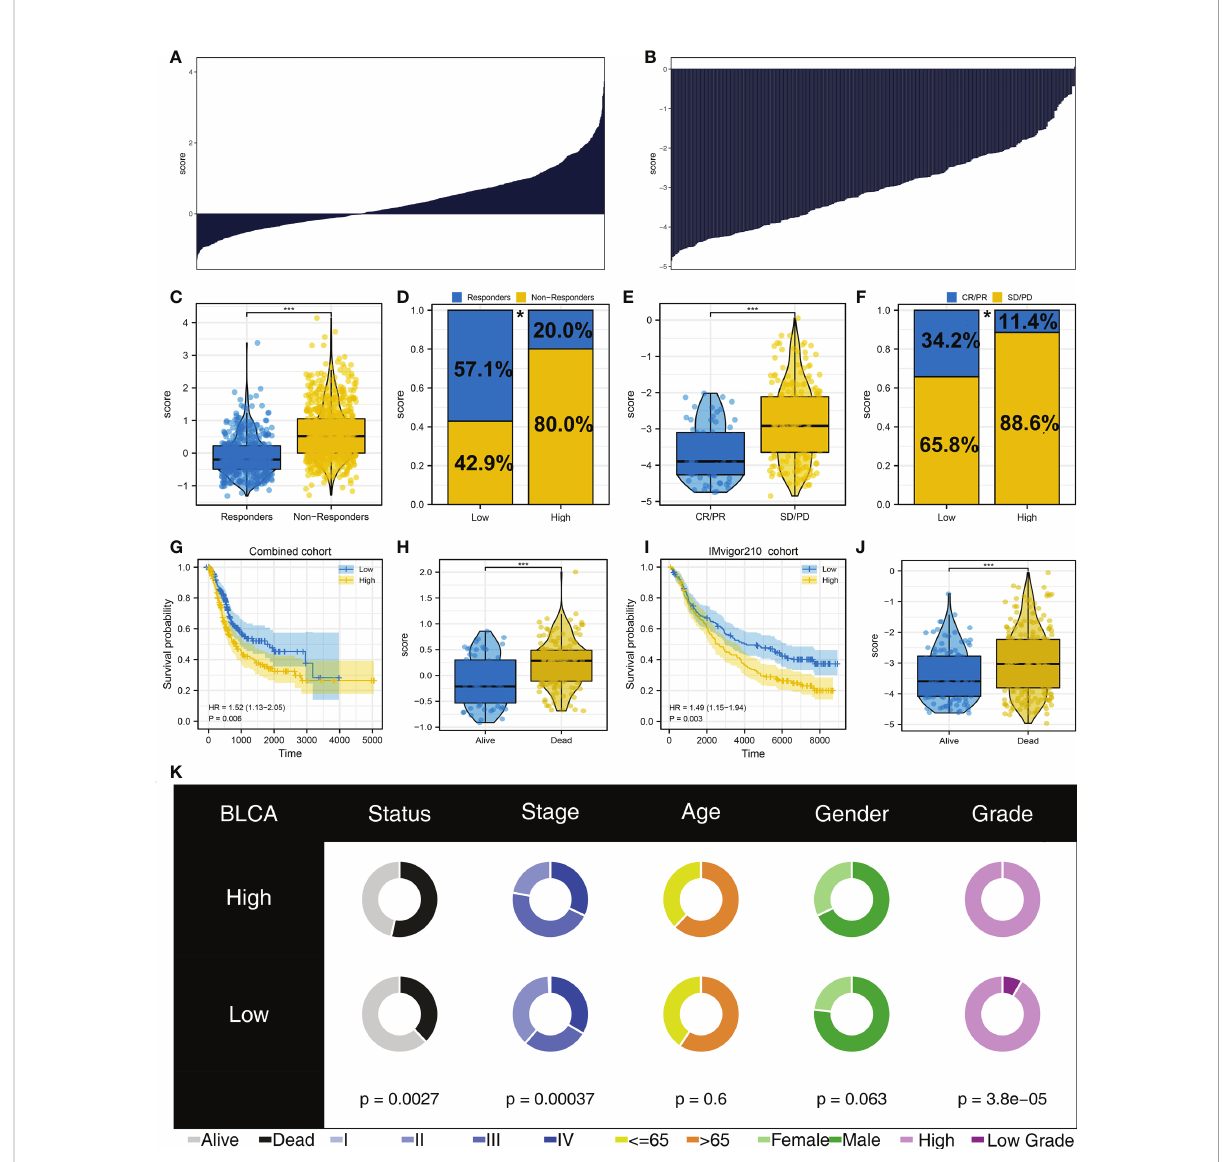
FIGURE 5 Logistics score was associated with patient immunotherapy response and prognosis (A) Calculated logistics score in the combined cohort. (B) Calculated logistics score in the IMvigor210 cohort. (C) Logistics score in immunotherapy responders and non-responders (combined cohort). (D) Percentage of immunotherapy responders and non-responders in patients with a high and those with a low logistics score (combined cohort), * p < 0.05. (E) Logistics score in immunotherapy SD/PD and CR/PR patients (IMvigor210 cohort). (F) Percentage of immunotherapy SD/ PD and CR/PR in patients with a high and those with a low logistics score (IMvigor210 cohort), * p < 0.05. (G) Kaplan – Meier survival curves in patients with a high and those with a low logistics score (combined cohort). (H) The level of logistics score in alive and dead cases in the combined cohort. (I) Kaplan – Meier survival curves in patients with a high and those with a low logistics score (IMvigor210 cohort). (J) The level of logistics score in alive and dead cases in the IMvigor210 cohort. (K) Clinical correlation analysis of logistics score. ***P <